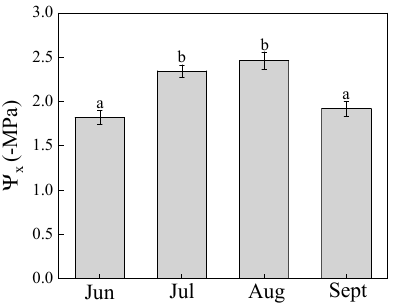
Figure 4. Change in twig water potential ( Ψ x ). Lower-case letters denote significance levels based on ANOVA post hoc means using LSD analysis ( p < 0.05). Data are means with standard error. Hydraulic conductance of whole-roots ( k root ) increased with increasing k shoot (R 2 = 0.222, p < 0.05,